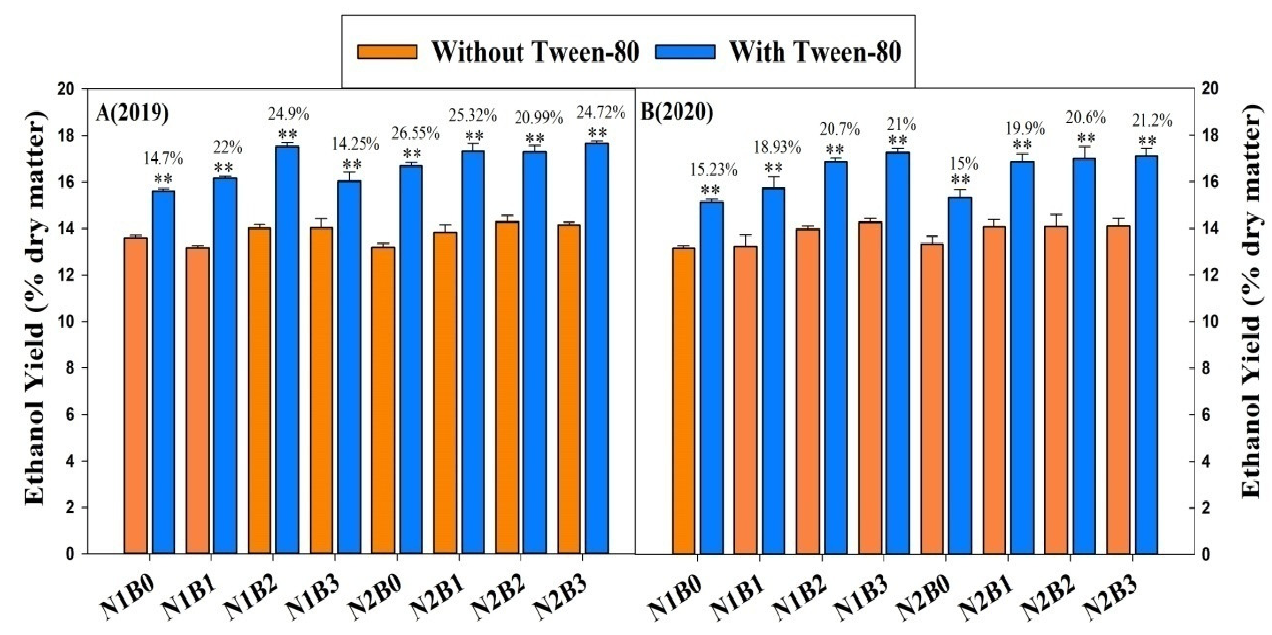
Figure 3. Impact of biochar and nitrogen fertilizer on bioethanol yields from biomass process in rice. ** above the column represent significant difference among the biochar and biochar treatments by t -test at p < 0.05 or p < 0.01 (n = 3). % value indicates the increase in the same treatment with Tween-80 from without Tween-80.